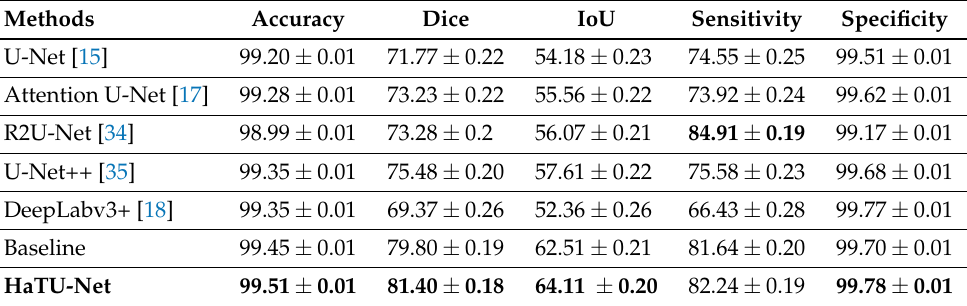
Table 4. Comparing of the proposed model for follicles segmentation with five state-of-the-art segmentation methods. Statistically significant results are highlighted in